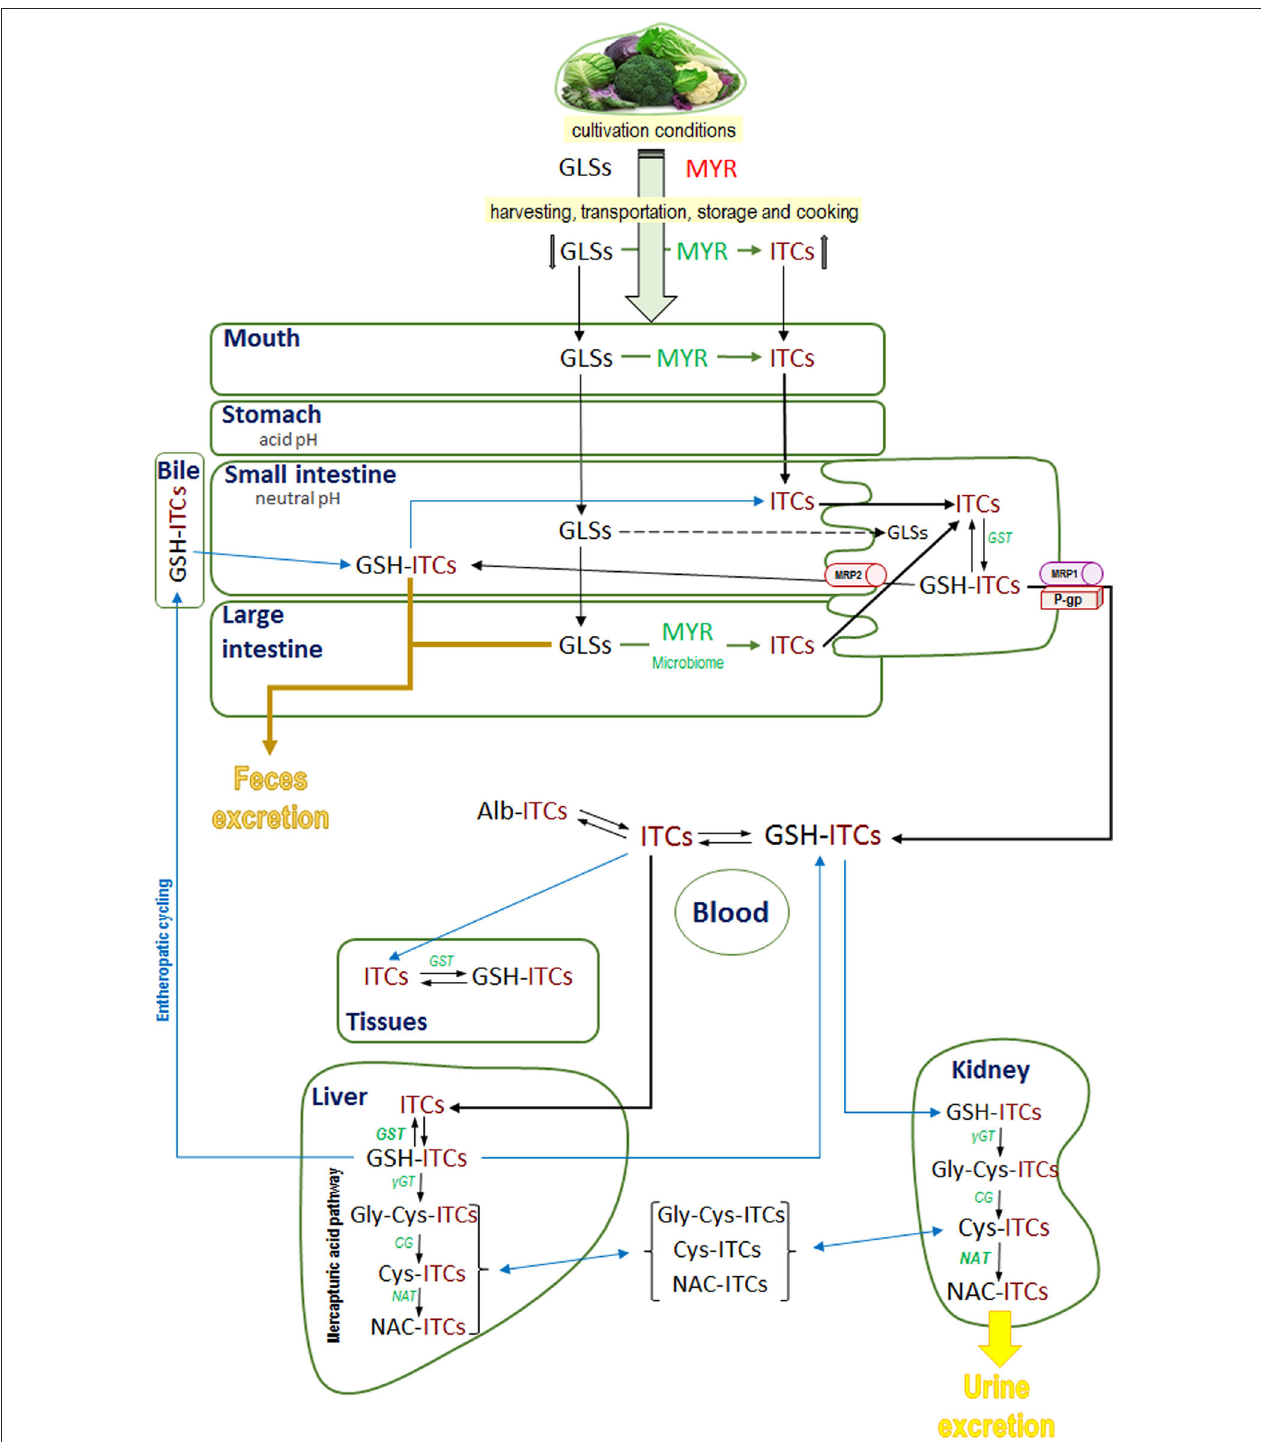
FIGURE 2 | General overview of ingested glucosinolates and isothiocyanates fate: mouth hydrolysis, microbiota hydrolysis, absorption, metabolism, and excretion. GLSs, glucosinolates; ITCs, isothiocyanates; MYR, myrosinase; GSH-ITCs, glutathione isothiocyanates conjugates; Alb-ITCs, albumin isothiocyanates conjugates; Gly-Cys-ITCs, glycine-cysteine isothiocyanates conjugates; Cys-ITCs, cysteine isothiocyanates conjugates; NAC-ITC, N-acetylcysteine isothiocyanates conjugates; GST, glutathione-S-transferase; γ GT, γ glutamyltranspeptidase; CG, cysteinylglycinase; NAT, N-acetyltransferase.